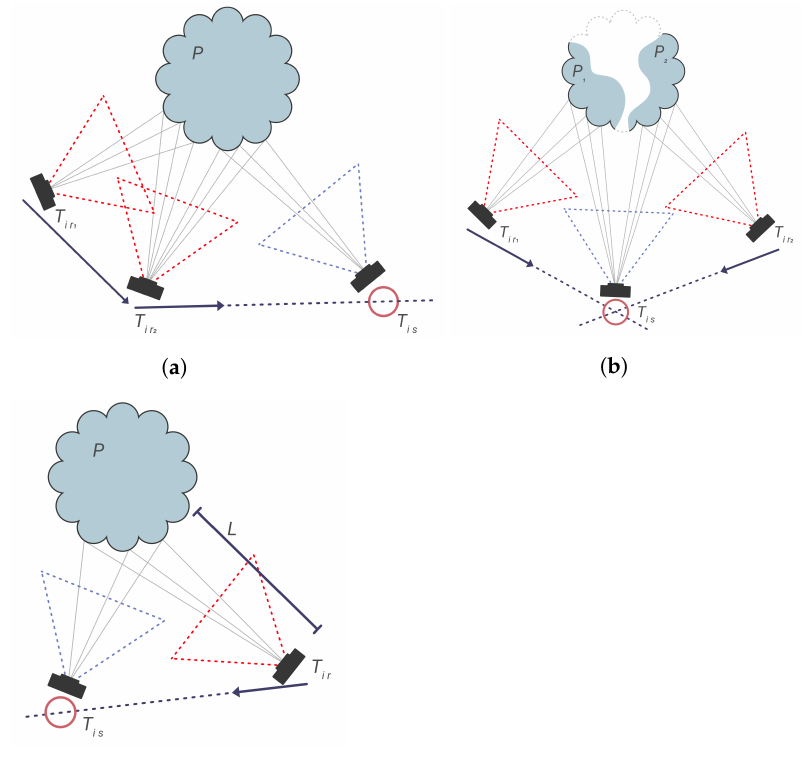
Figure 6. ( a ) Two overlapping references: T i is retrieved from a direct pose estimation of the recon- s structed X matches between i r and i r . ( b ) Two separate references: T i is retrieved by triangulating 2 1 s its pose from the individual matches between i s and i r and i r , respectively. ( c ) One reference image 2 1 with geometry: X is scaled based on the raycast-distance L to x on the geometry. Overview of scale estimation for different XR image alignment possibilities: ( a ) multiple reference matches with a single session image, ( b ) single reference match with multiple session images, and ( c ) single reference match with a single session image but depth information is